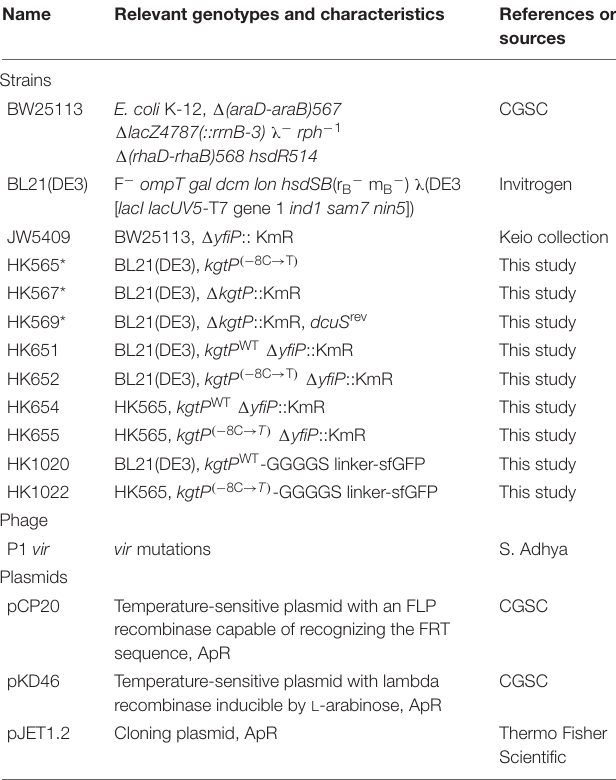
TABLE 1 | Bacterial strains, phage, and plasmids used in this